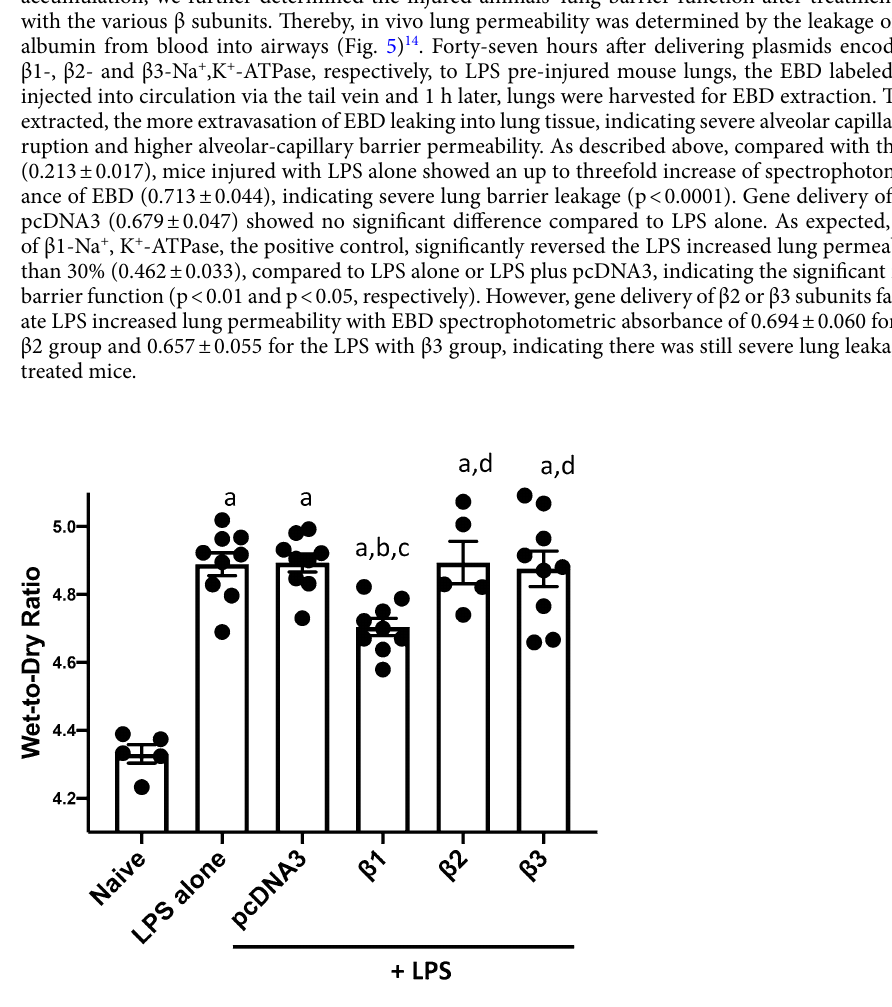
Figure 4. Gene transfer of β2 or β3 subunits of the Na + ,K + -ATPase into mouse lungs with existing LPS- induced injury failed to reduce lung edema. Lung injury was established in C57B6 mice (n = 9) by aspiration of LPS (5 mg/kg) and 1 day later plasmids (100 μg each) expressing either no insert (pcDNA3), the β1, β2, or β3 subunits of the Na + ,K + -ATPase (β1, β2, or β3) were delivered in 50 μl to the lungs by aspiration